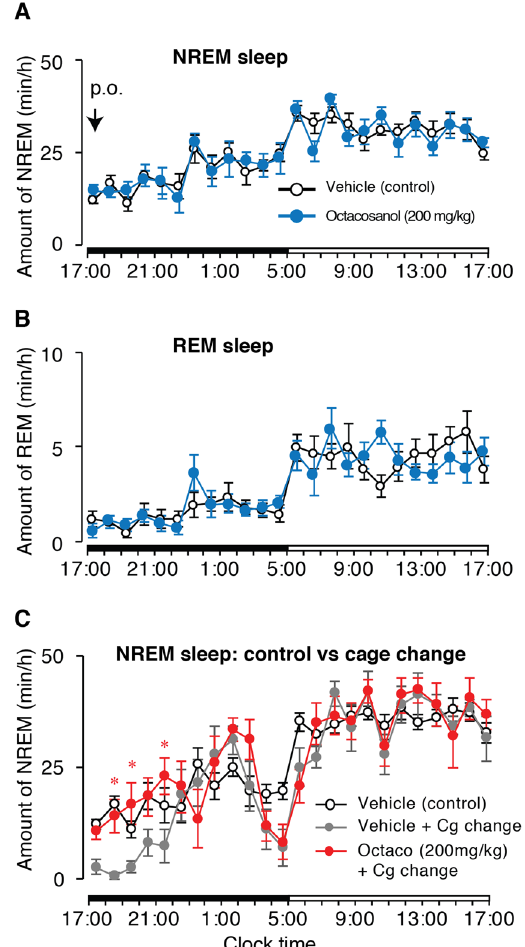
Figure 1. Effect of octacosanol oral administration in mice on sleep-wakefulness. Hourly plots of NREM ( A ) and REM ( B ) sleep after oral administration of vehicle (open circles) or octacosanol (blue circles). ( C ) Hourly plots of NREM sleep in mice after p . o . administration of vehicle (gray circles), octacosanol (red circles) with cage change, and control (vehicle with no cage change; open circles). Black and white horizontal bars indicate 12-h dark and 12-h light period. Data presented as mean ± SEM; n = 5–8; * p ≤ 0.05 vs veh + cg change by using two-way ANOVA. Cg: cage; octaco: